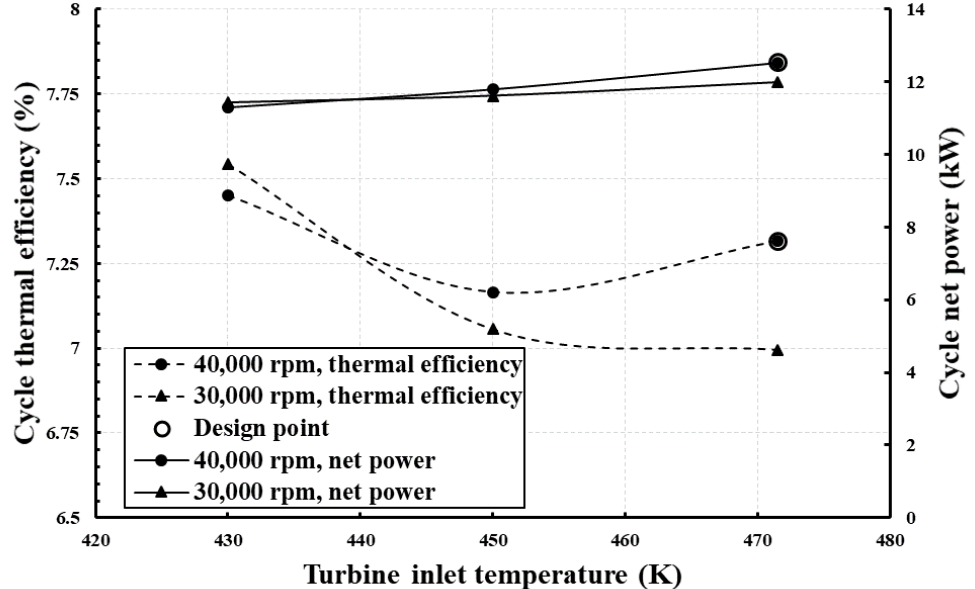
Figure 27. Cycle thermal efficiency and net power at various turbine inlet temperatures.